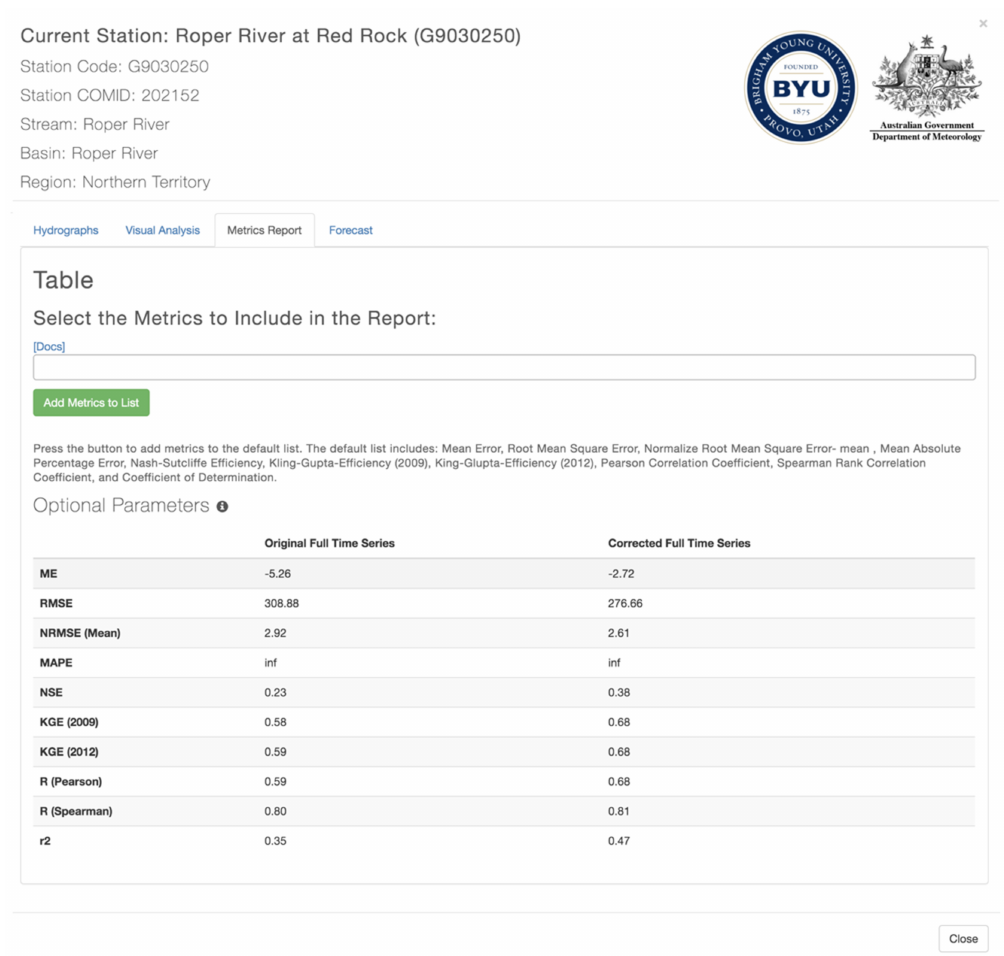
Figure 8. Metrics report for the Roper River at Red Rocks (G9030250) station for the HVT App for